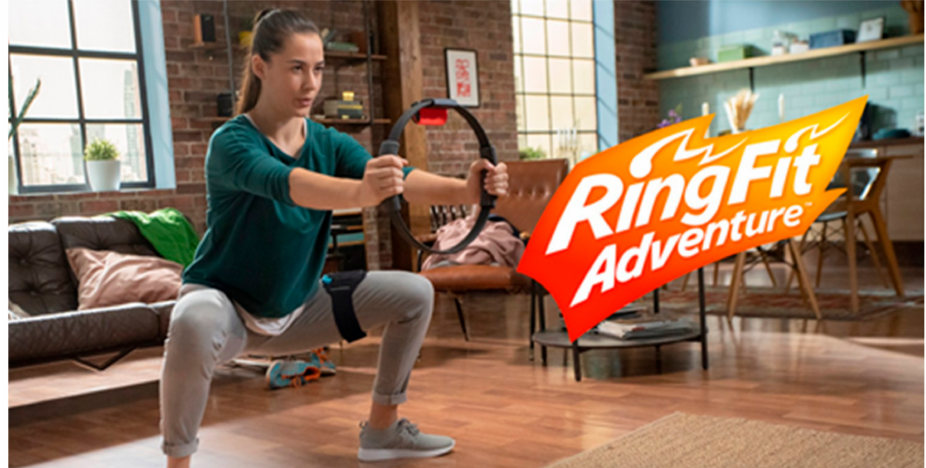
Figure 3. Nintendo Ring Fit Adventure (Source: